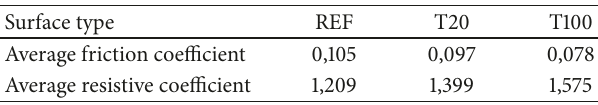
Table 3: Average friction coefficient and average resistive coefficient for each surface